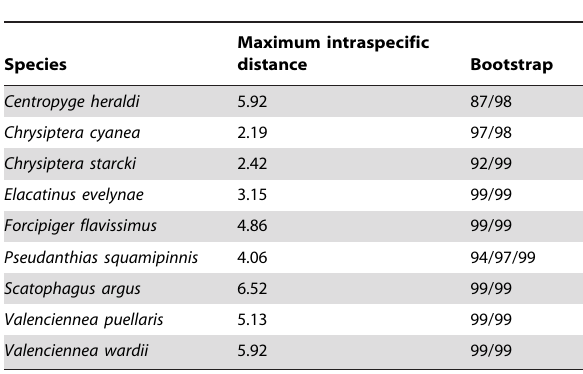
Table 1. Provisional splits of recognized species with intraspecific distances above the 2.0% threshold. Bootstrap supports for provisional species clusters are